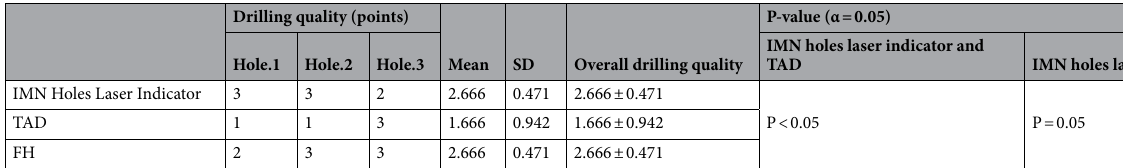
Drilling quality (points)